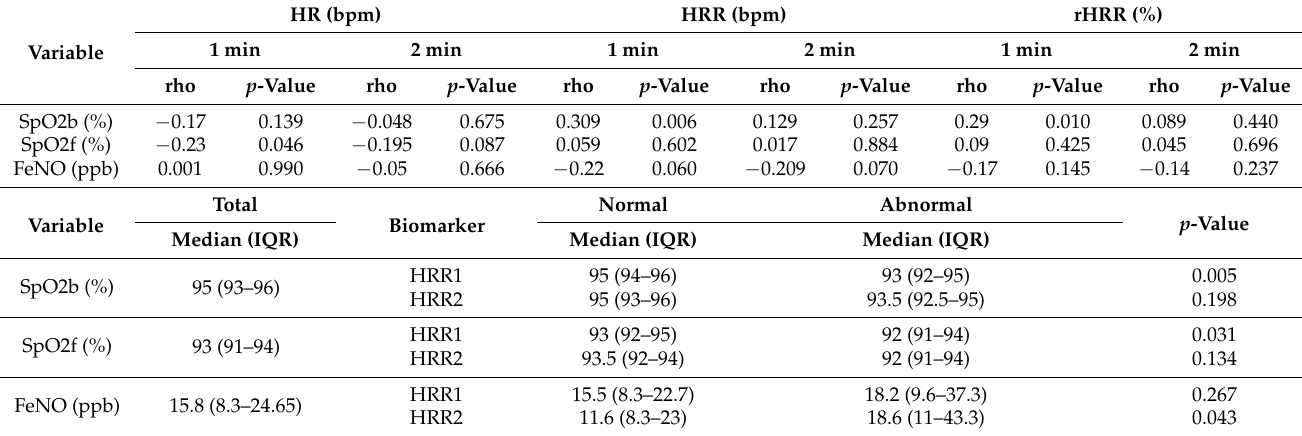
Table 3. General characteristics of the population recruited by National Institutes of Health, Mexico City.